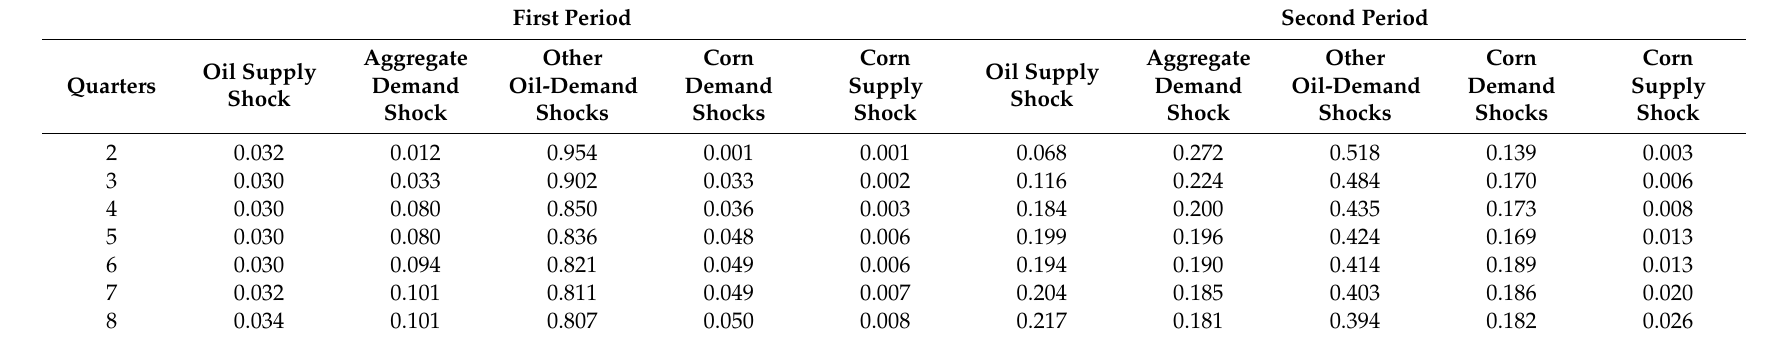
Table 4. Percentage contribution to oil price variation (before the decomposition of corn demand).